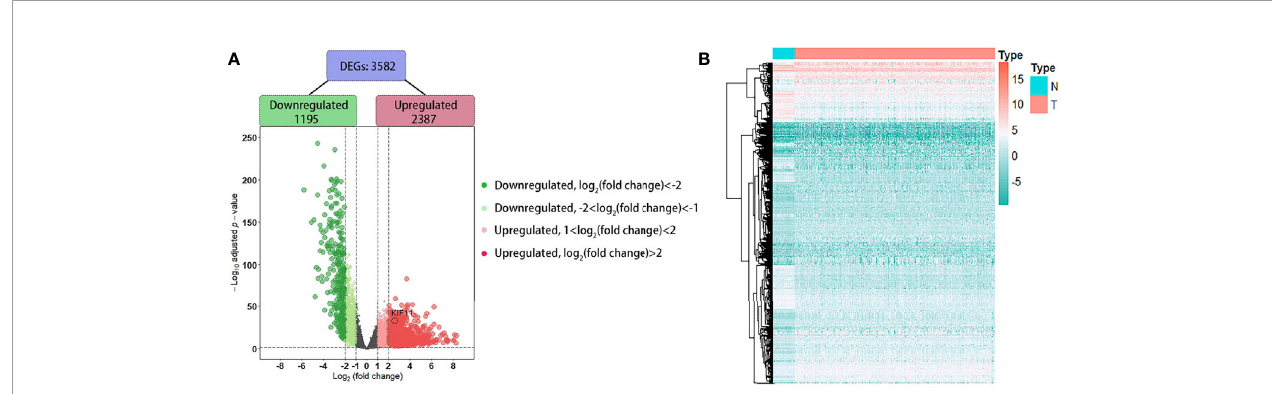
FIGURE 2 | Identi fi cation of differentially expressed genes (DEGs) based on the TCGA dataset. A volcano plot depicts the 3, 582 DEGs in LUAD tissues versus normal lung samples (A) . An adjusted p-value <0.05 and |log2(fold change)|>1 were the cutoff criteria. A heatmap of the DEG expression pro fi les (B) . Column names indicate the sample ID; row names depict the DEG